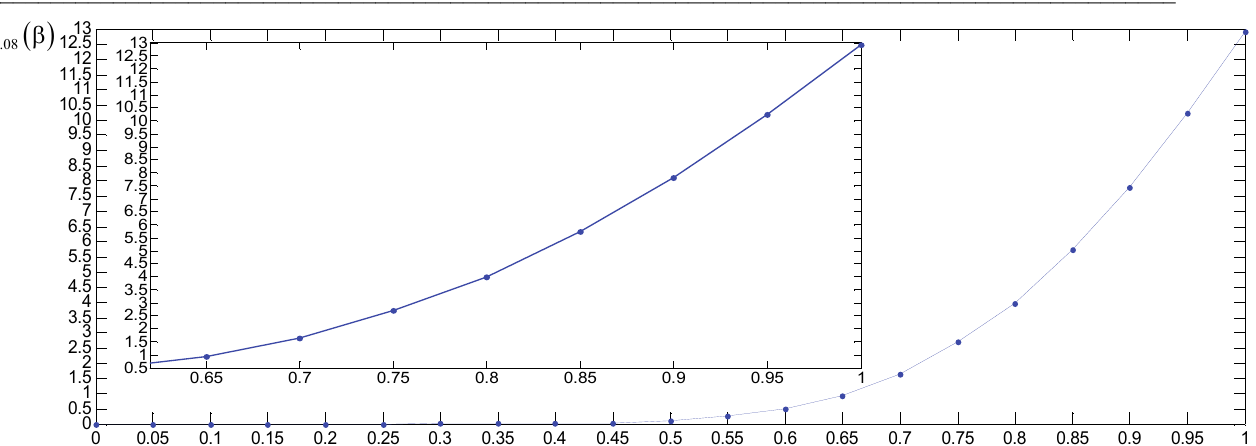
Fig. 5. A disclosure of the best CEP across the increasing distortions (here, it is shifting). At expected practicable SDs, only one object of 61 ones is misclassified.